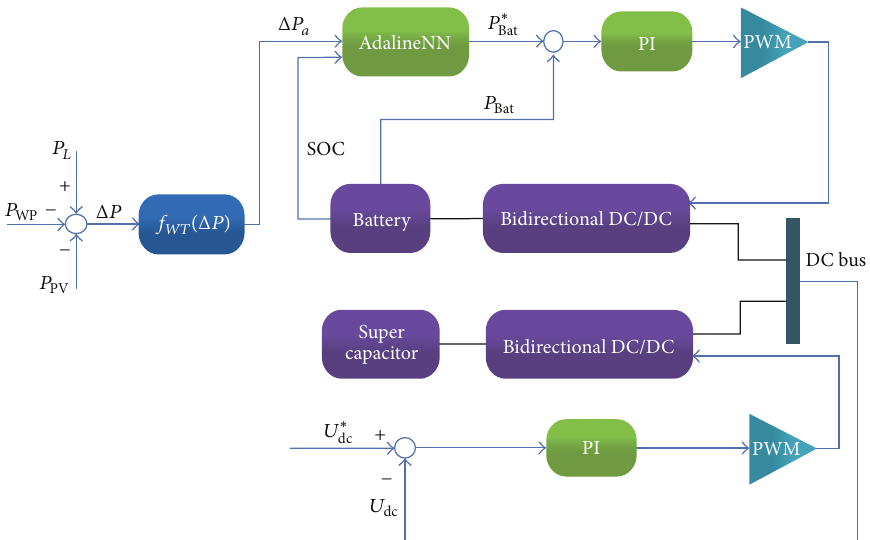
Figure 10: Wavelet and neural network controller based energy management system.